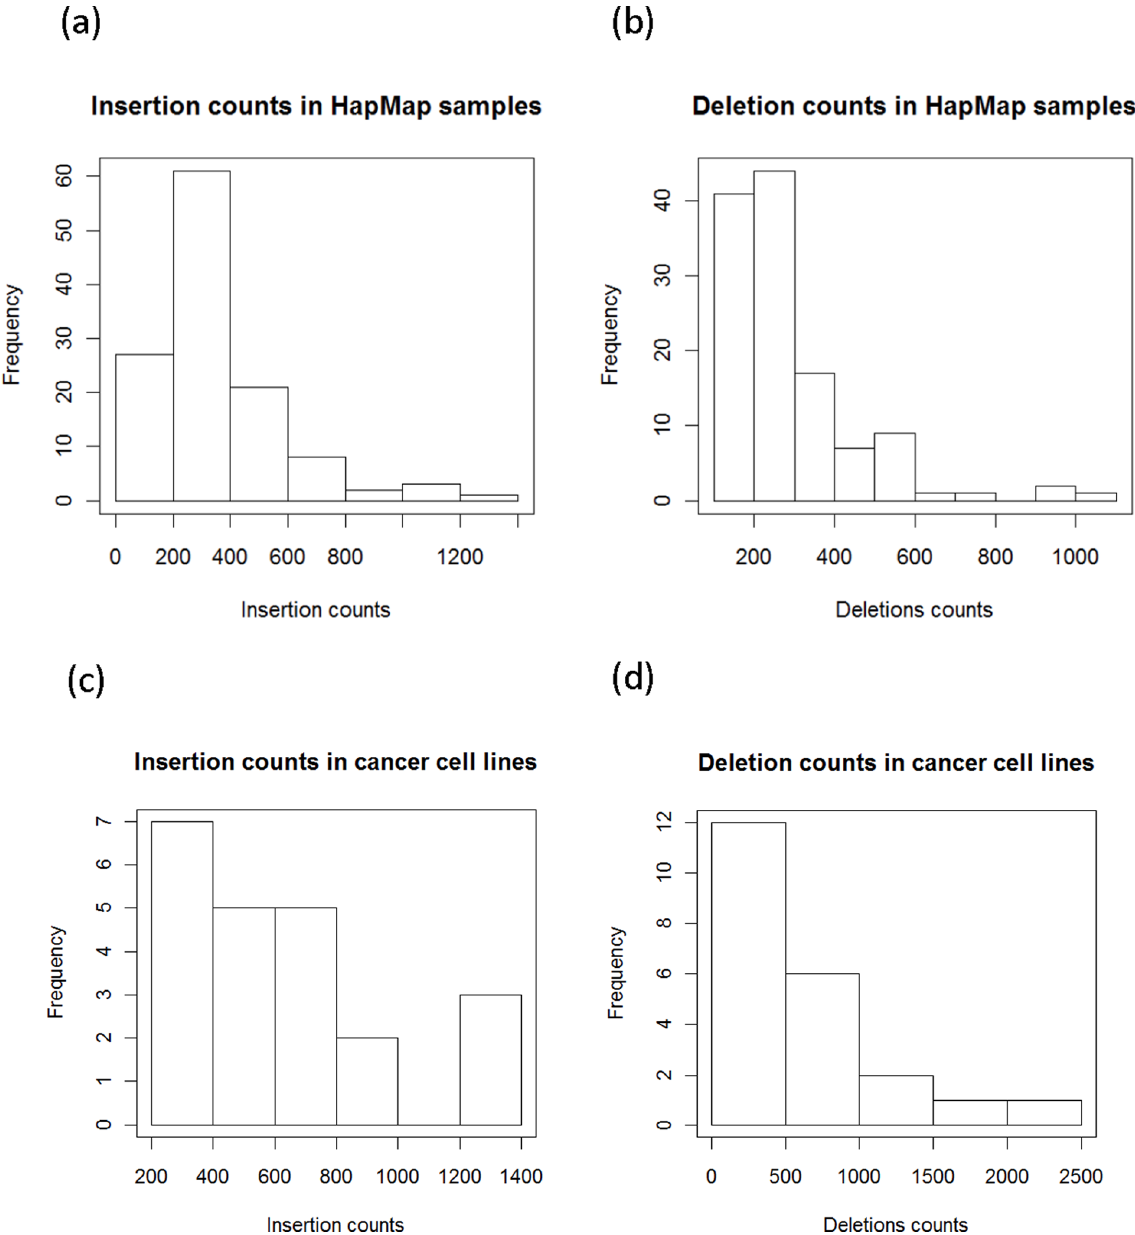
Figure 2. Indel counts from RNA-Seq. Y axis shows the number of samples. (a) HapMap samples (b) cancer cell lines.